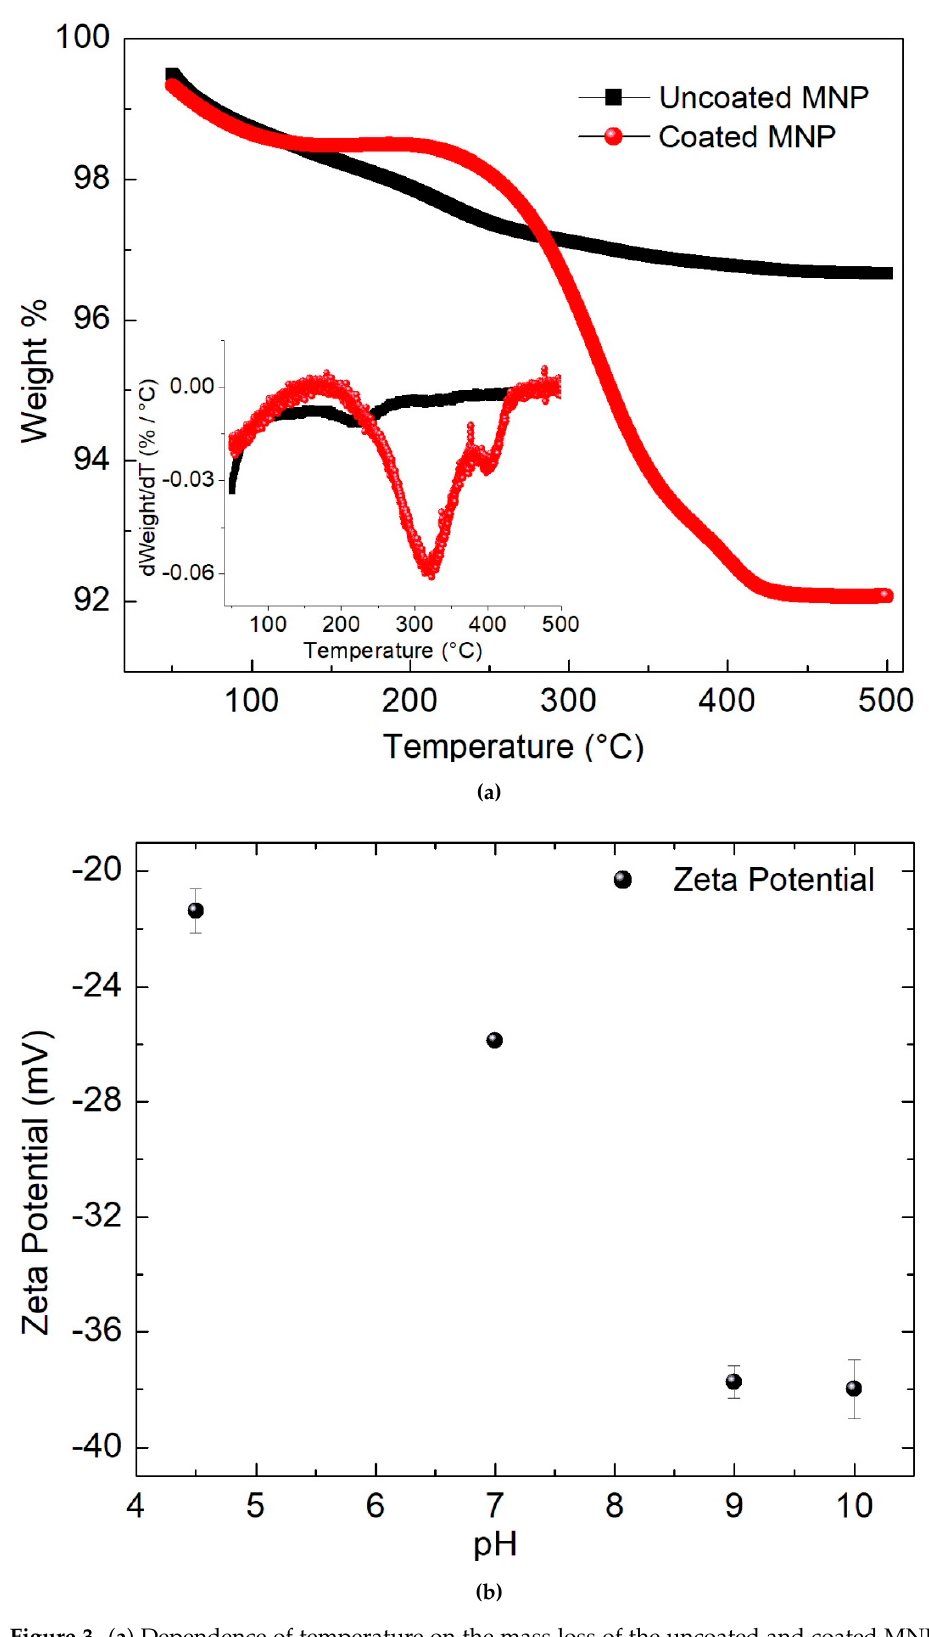
Figure 3. ( a ) Dependence of temperature on the mass loss of the uncoated and coated MNPs, the inset are the derivatives of the mass loss plot, and ( b ) the zeta potential variation between pH = 4.5 and